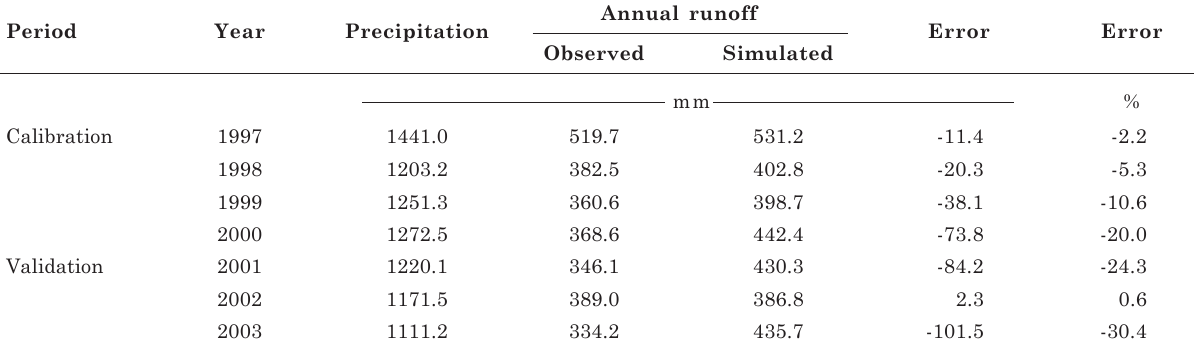
Table 3. Observed and SWAT-simulated annual runoff in the Galo creek watershed during calibration and validation